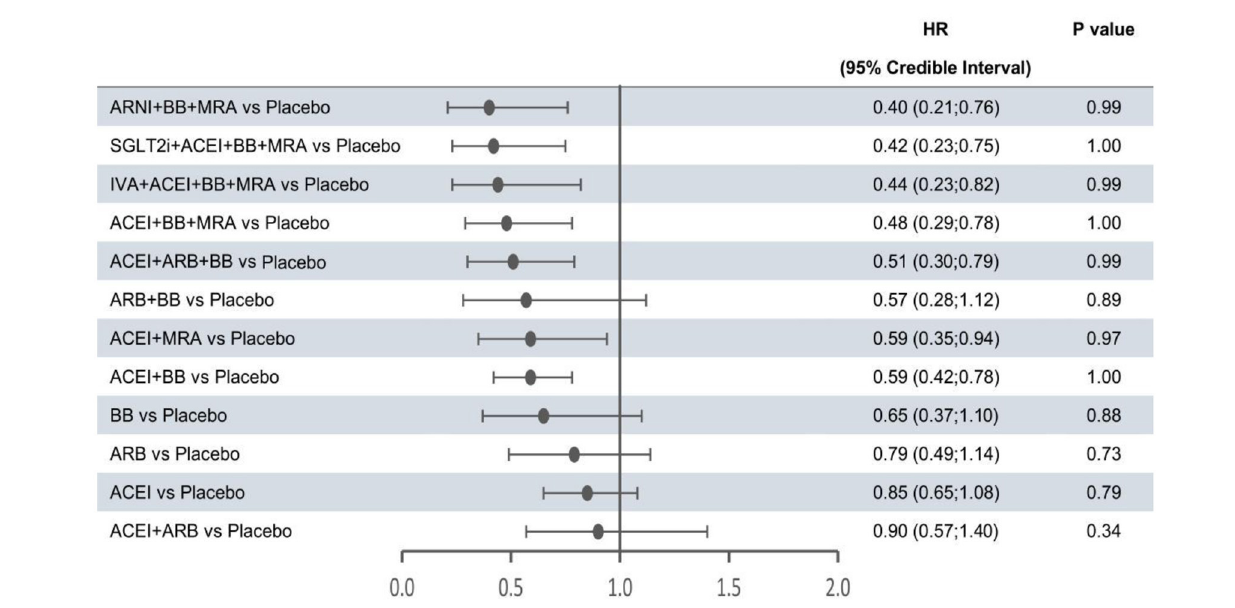
FIGURE 2 | Efficacy of treatments vs. placebo in all-cause mortality. All-cause mortality was reported as hazard ratios (HRs) and 95% credible intervals for treatment vs. placebo. P -values were calculated based on the 95% credible intervals of hazard ratios and indicated the probability that the treatment was better than placebo. ACEI, angiotensin-converting enzyme inhibitor; ARB, angiotensin receptor blocker; ARNI, angiotensin receptor-neprilysin inhibitor; BB, beta-blocker; IVA, ivabradine; MRA, mineralocorticoid receptor antagonist; SGLT2i, sodium-glucose cotransporter 2 inhibitor.